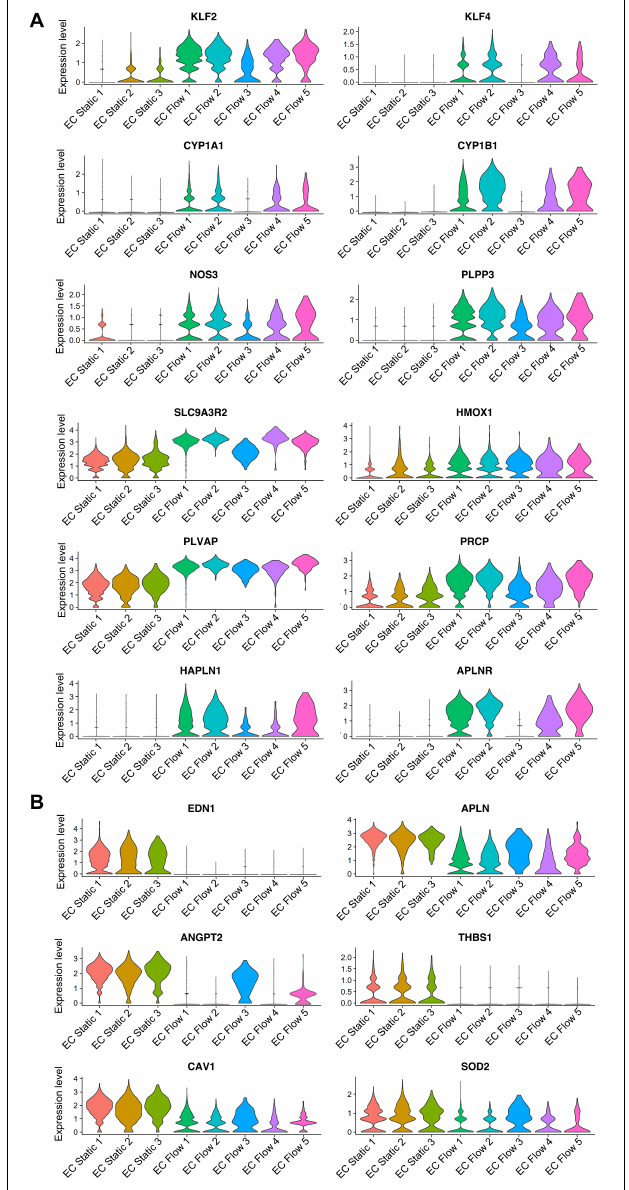
FIGURE 5 | The effect of flow on hiPS-EC gene expression (HEL47.2). (A) , Violin plots for selected genes upregulated by flow. (B) , Downregulated genes in response to